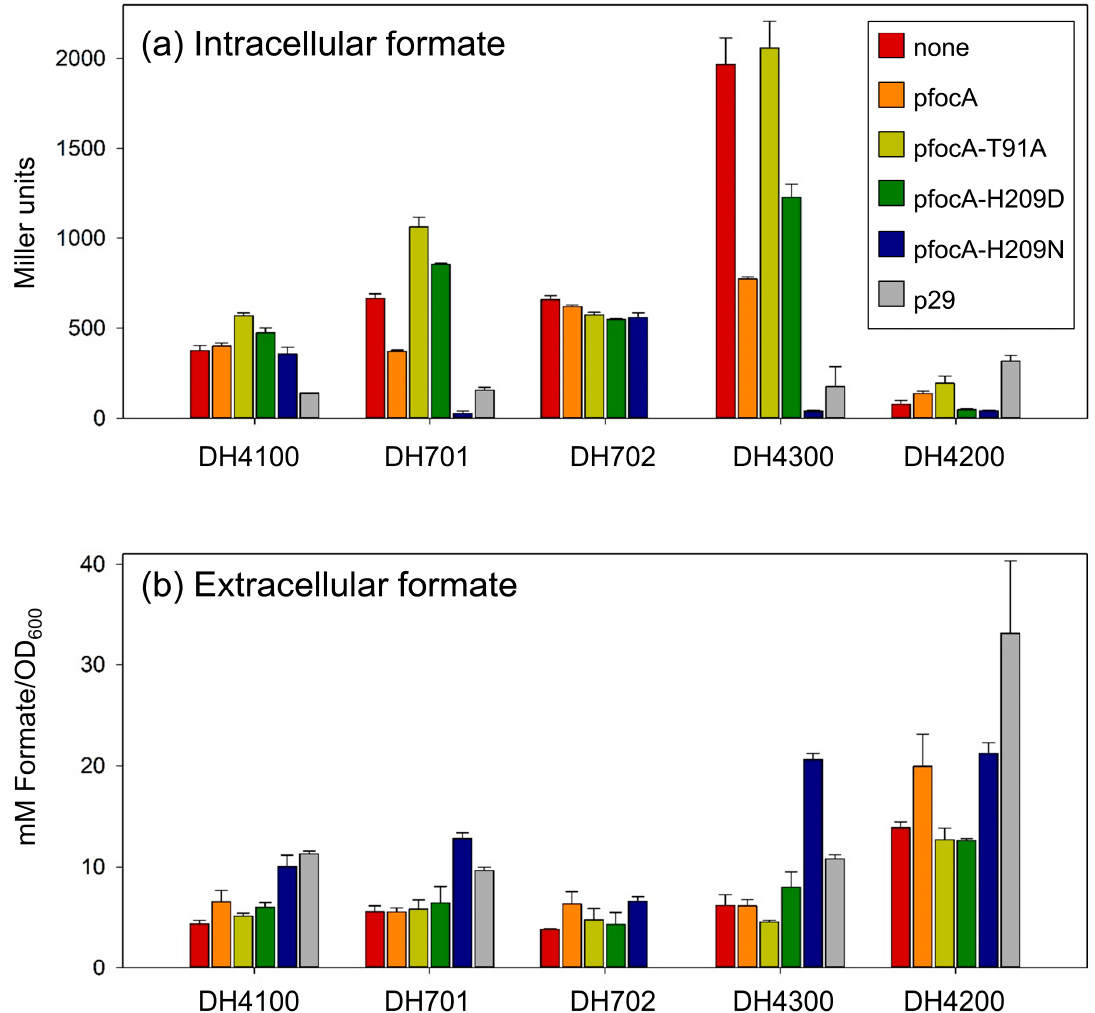
Figure 3. Strains with a genomic copy of the native focA-pflB operon maintain intracellular formate homeostasis during fermentative growth. Changes in intracellular ( a ) and extracellular ( b ) formate levels were monitored as indicated in the methods section. The strains indicated on the x-axis included the parental wild-type strain DH4100, the focA mutant DH701, strain DH702 with the translation initiation codon of the chromosomal focA gene changed to ATG, strain DH4300 encoding FocA T91A , and strain DH4200 encoding FocA H209N . Due to the introduction of the more efficient ATG translation initiation codon into the focA gene in strain DH702, 10-fold more FocA is synthesized in these cells [9]. Each strain was transformed with either no plasmid (red), pfocA (orange), pfocA-T91A (pale green), pfocA-H209D (dark green), pfocA-H209N (dark blue), or p29 (grey). Note that plasmid p29 was not tested in strain